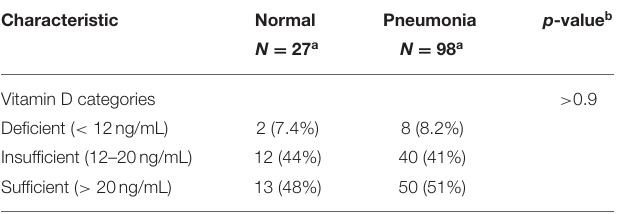
TABLE 9 | The association between serum 25(OH)D levels (deficient, insufficient, sufficient) and radiological findings of the patients. Characteristic Normal Pneumonia p -value